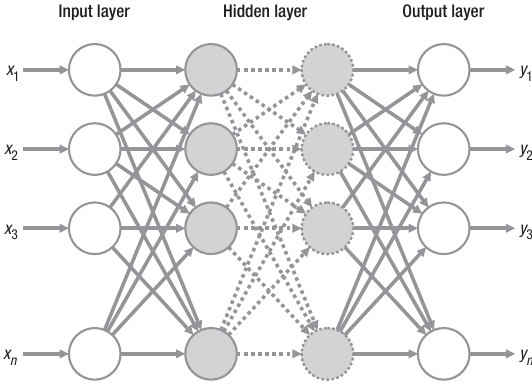
Fig. 3. A typical arti fi cial neural network